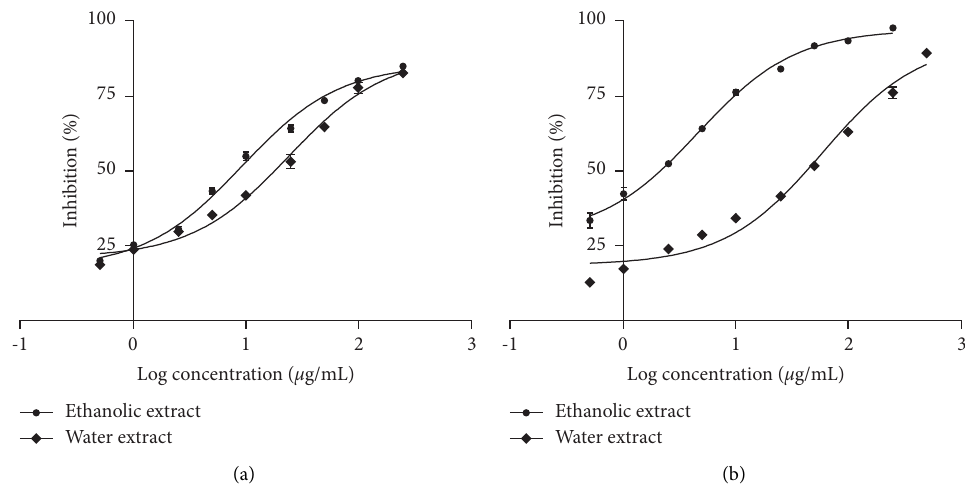
Figure 1: Concentration-dependent response of C. spectabilis fower extracts against AChE (a) and BChE (b); each value is expressed as means ± SEM ( n � 3).